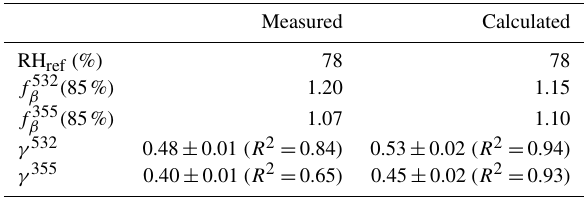
Table 3. Results obtained for the hygroscopic case on 16 June 2016, evaluated with RL (IISTA-CEAMA station) and in situ (SNS) sta-